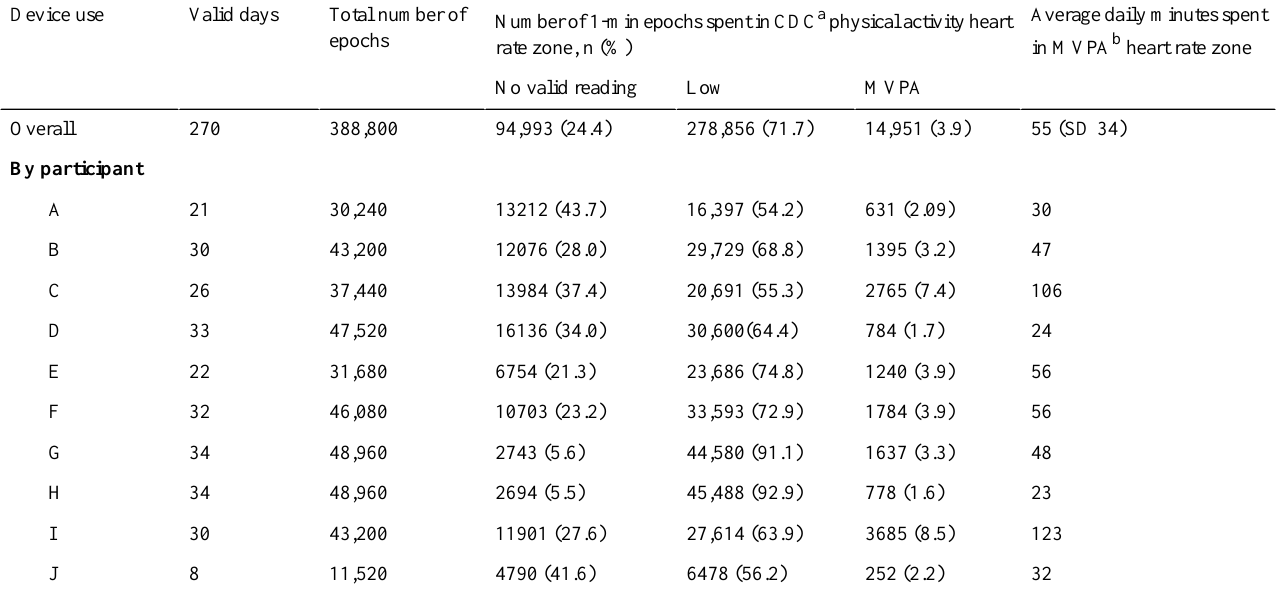
Table 4. Free-living data collection. Over n=270 valid person-days of Fitbit usage.